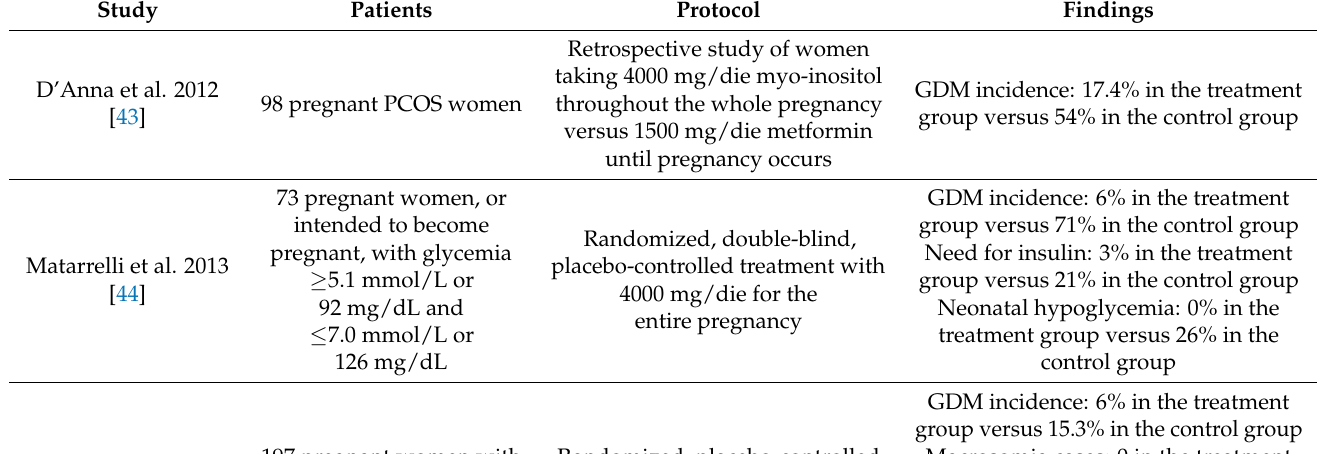
Table 3. Studies involving myo-inositol as a preventive treatment against GDM